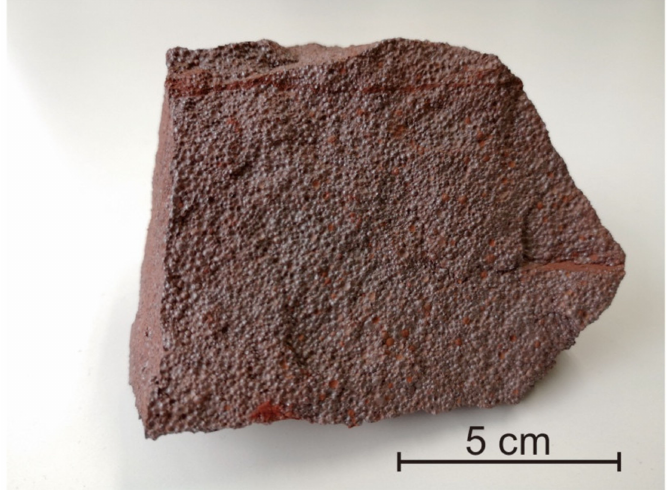
Figure 1. Oolitic hematite from the Chuanlinggou formation (ca. 1.65 Ga), North